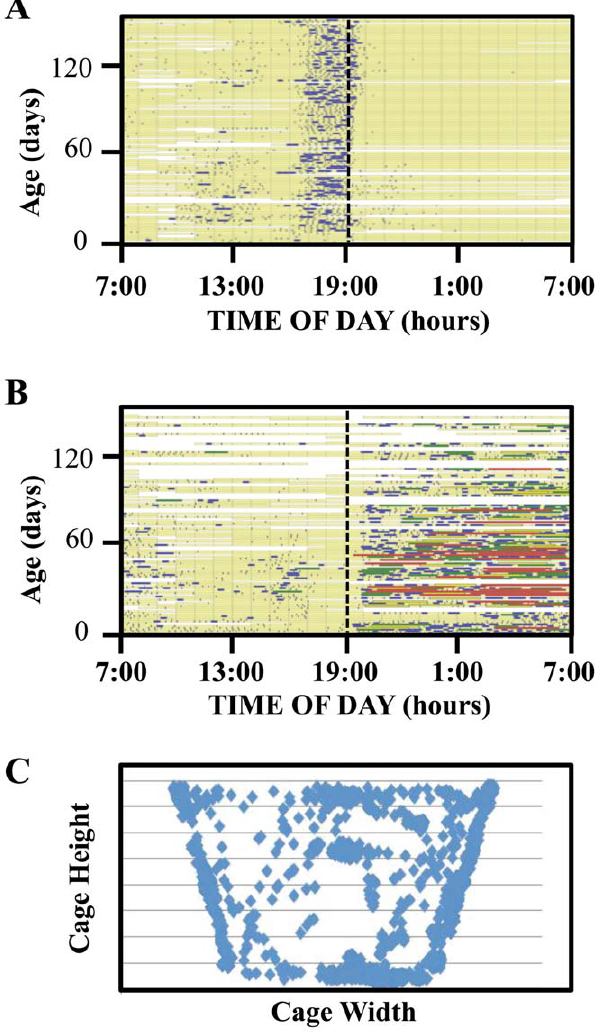
Figure 2. Behavior patterns of a single fly. ( A ) Event history chart for a representative individual fly on full diet depicting the patterns of walking by age and time-of-day (indexed at time 7:00 for lights on; 19:00 for lights off). Each day of the fly’s life is shown as a horizontal line divided into 24 one-hour segments, each of which codes the 2 or 3 one- minute recordings per hour. Code: walking=blue; not walking=yellow; blank/white=no data. Lines containing the time-of-day information are ordered by age from bottom (youngest) to top (oldest). ( B ) Event- history chart for a representative individual fly on full diet showing the duration of rest (sleep-like) bouts (pale yellow = recorded data; blue, green, yellow, and red denote rest durations of , 1, 1–2, 2–3, and . 3 hrs, respectively). ( C ) Spatial graphic depicting the 24-hr within- cage movement of a 30 day-old female A. ludens . Only the front view is shown.